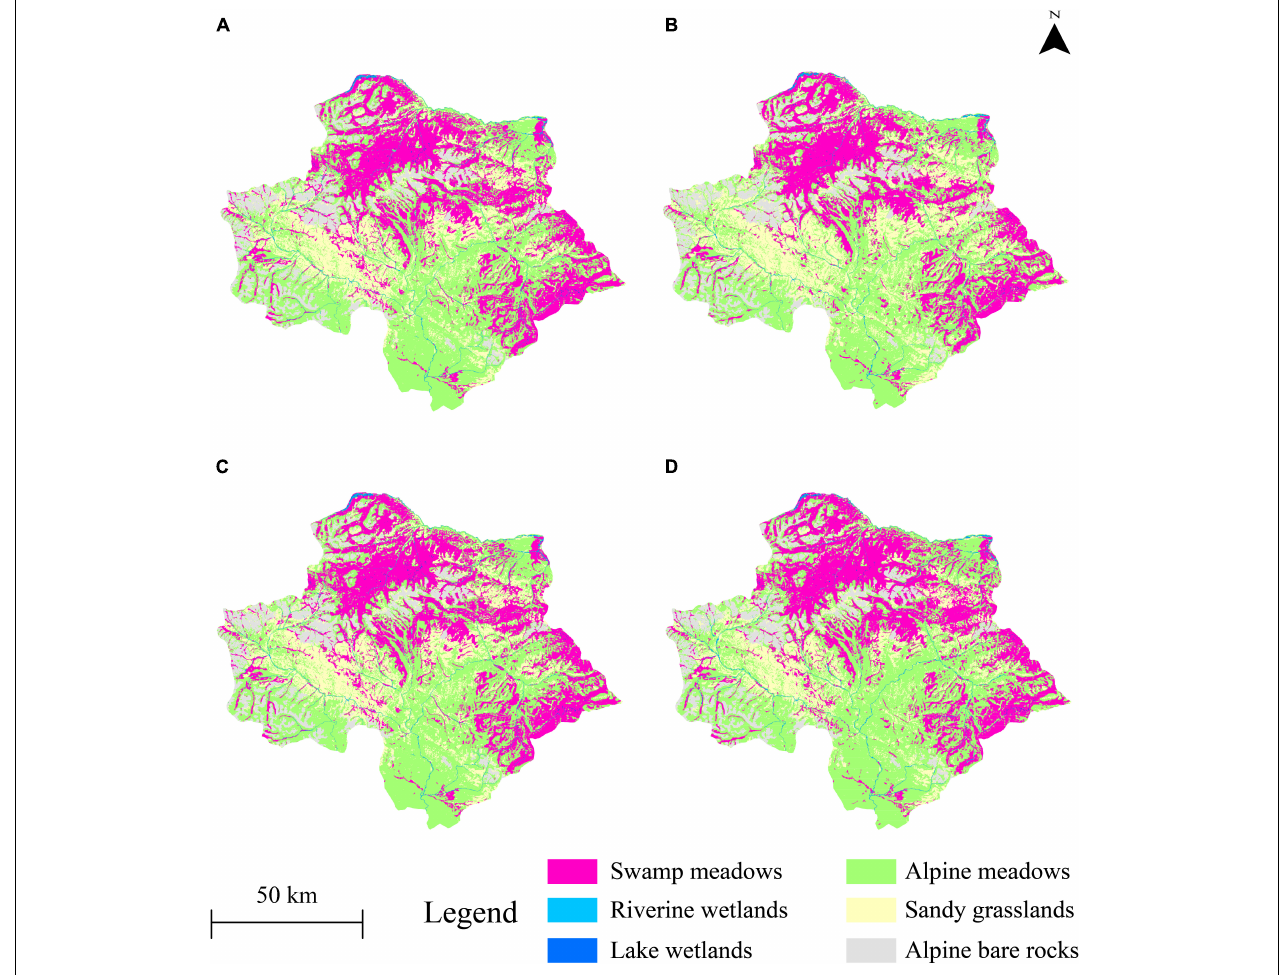
FIGURE 3 | Distribution of various landscape types in the Changshagongma Wetland Nature Reserve in the four periods. (A) 1992, (B) 2002, (C) 2013, (D)